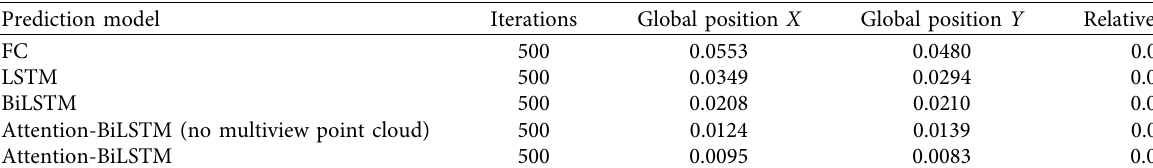
Table 1: The prediction effect of each model.